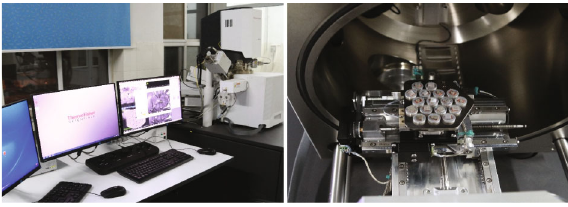
Figure 7: The picture of